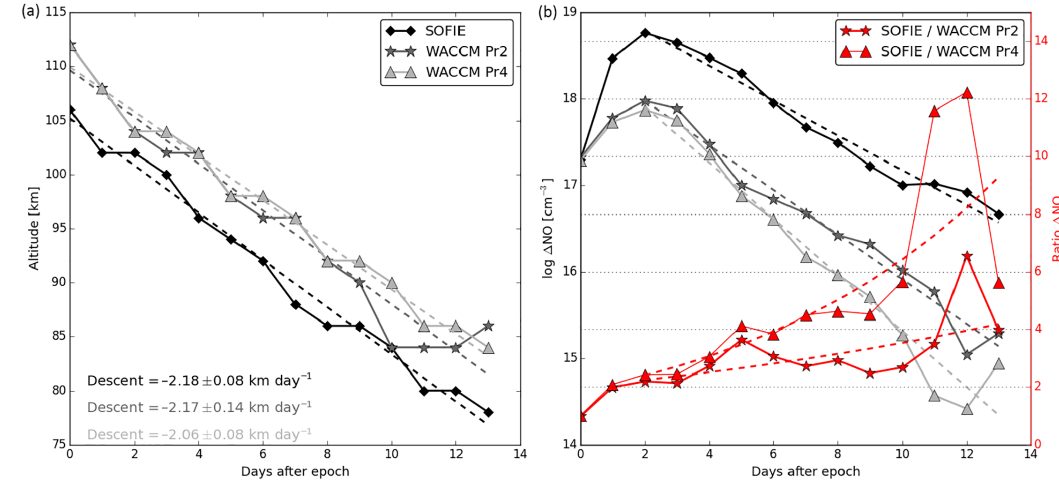
Figure 11. (a) Altitude of the maximum NO enhancement after the onset of geomagnetic activity for SOFIE and WACCM with enhanced diffusion (WACCM Pr2, obtained from Fig. 10) and for a control run with standard eddy diffusion (WACCM Pr4). The slope of a linear regression fit (dashed lines) represents the MLT descent rate. (b) The maximum NO enhancement at each corresponding day after the epoch, and at the corresponding altitude as shown in the left panel, that is transported downward (also obtained from Fig. 10). An exponentially decreasing fit (dashed black and grey lines) is performed onward from day 2, when the largest NO enhancement is reached. The ratio between SOFIE and WACCM NO enhancements (fit) is shown by the full (dashed) red line.